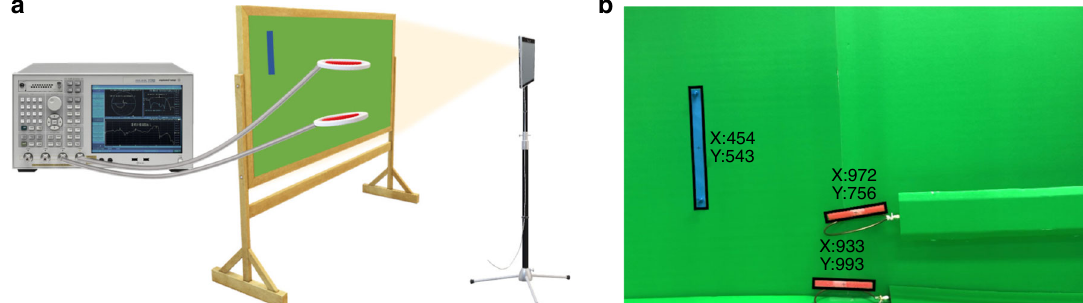
Fig. 7 Measurements. a Schematic representation of measurement setup. b The camera frame sample after video processing for object tracking and extracting red and blue markers attached to coils and the fi xed-length calibration label, respectively.